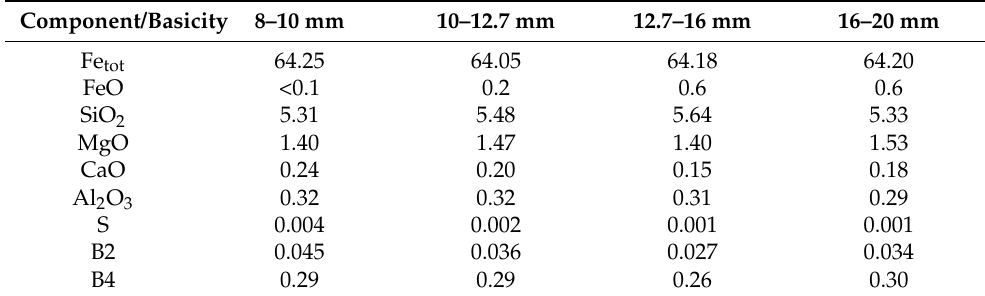
Table 1. Chemical composition (in wt.%) and basicity for different-sized pellets.